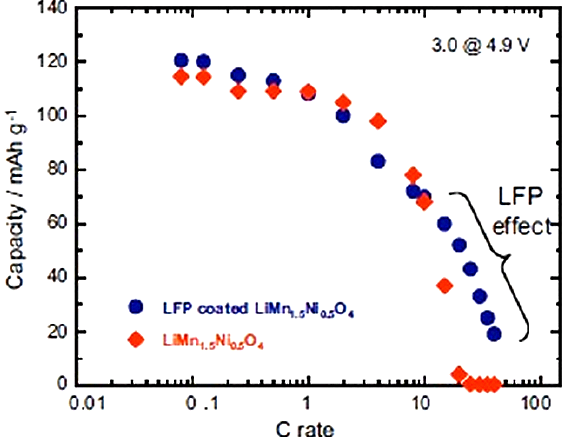
Figure 9. Modified Peukert plot of the Li//C-LiFePO cells between 3.0 and 4.9 V. (Reprinted with permission from [66]. Copyright 2012